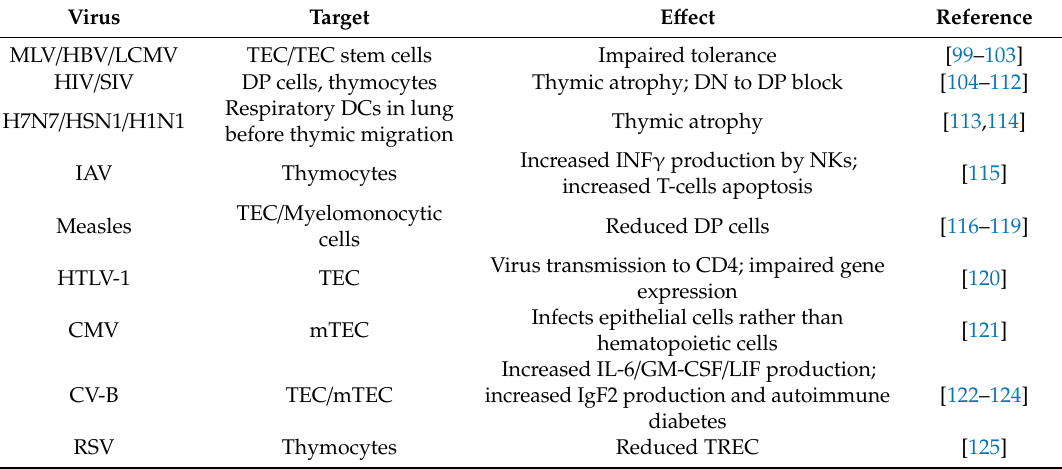
Table 5. Impact of viruses on